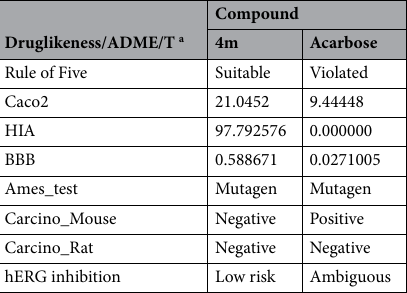
Table 3. Druglikeness/ADME/Toxicity prediction of the most active compound 4m and acarbose. a The recommended ranges for Caco2: < 25 poor, > 500 great, HIA: > 80% is high < 25% is poor, and BBB = − 3.0 −